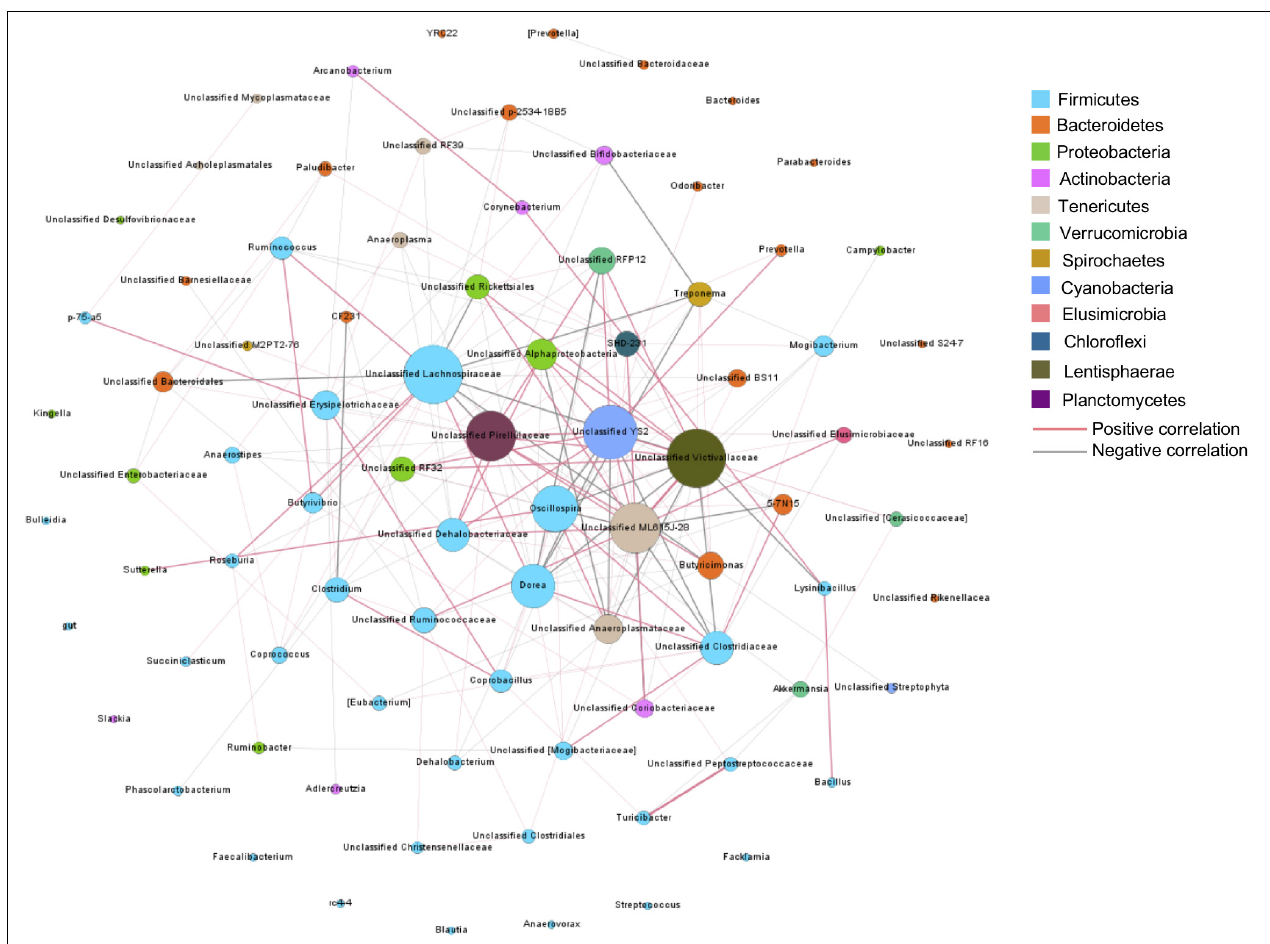
FIGURE 5 | Co-occurrence bacterial network. Each co-occurring pair has an absolute Spearman rank correlation above 0.3 with an FDR-corrected significance level under 0.05. Dot size represents the number of connections with other taxa. Thickness of lines represents the strength of the